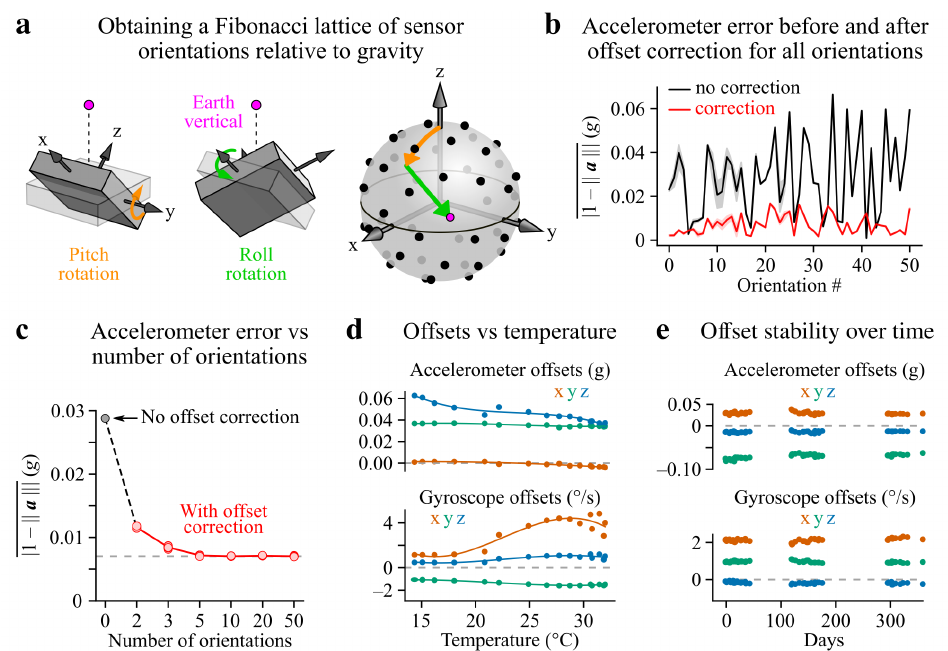
Figure 1. Sensor offset calibration. ( a ) A two-axis (pitch and roll) motorized rotation stage was used to orient the line of gravity (purple dot) along a series of 50 homogeneously distributed directions (black dots) in the sensor’s reference frame (see Section 2.5). The orange and green arrows on the right represent the trajectory of the gravity line during consecutive pitch and roll rotations. ( b ) Absolute acceleration error ( | 1 − (cid:107) a (cid:107)| , where a is the acceleration vector) during immobility for all tested orientations, with or without offset correction (data from one example sensor, n = 10 repetitions of the test). Shaded areas represent the 5–95th percentile range. ( c ) Average absolute error in the norm of measured acceleration as a function of the number of orientations ( N ) used to compute the offsets (data from one example sensor). Red points represent the values obtained with 10 repetitions of the test, with red lines connecting their average values. For N ≥ 5, a subset of the 50 orientations was selected to best match a homogeneous distribution on the sphere for N points; for N = 2 and N = 3, the set of orientations was selected to be the one corresponding to the mode of the error distribution computed using all possible combinations of N points, which for N = 3 corresponded to orthogonal point configurations. ( d ) Effect of the temperature on acceleration and gyroscope offsets for one example sensor. The lines represent cubic polynomial regressions. ( e ) Stability of gyroscope and accelerometer offsets for one example sensor over a